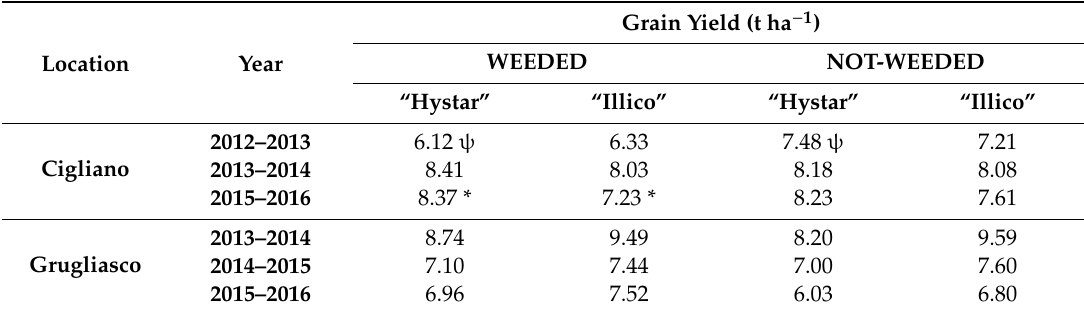
Table 6. Grain yields recorded at the two locations in the studied period.